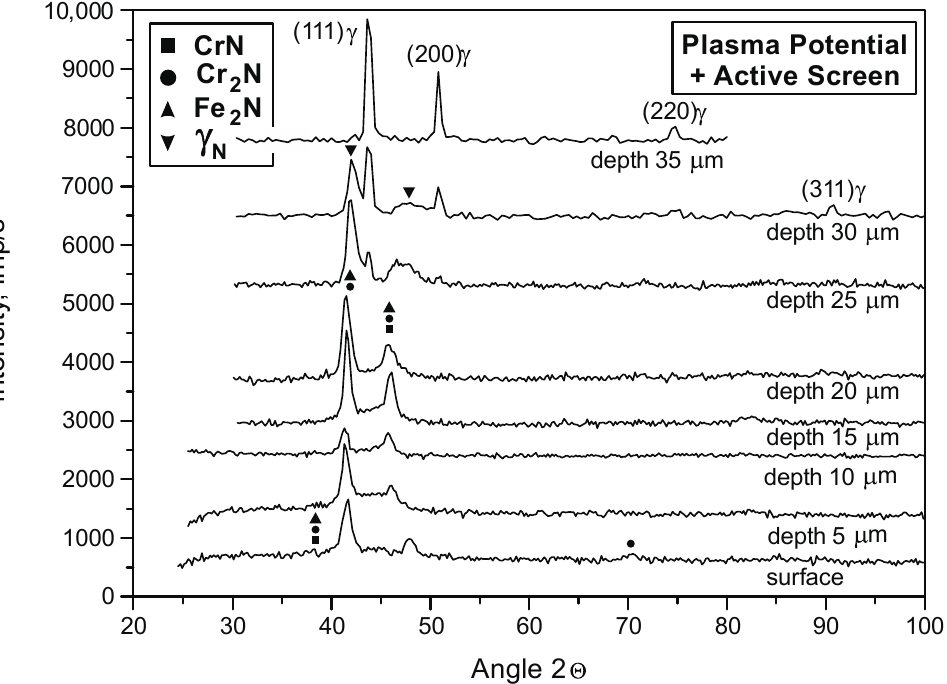
Figure 4. Diffractograms of the nitrided layer on the substrate of 316L steel depending on the depth in the cross-section of the surface layer. Nitriding in plasma potential + active screen, T = 490 °C, t = 8 h.